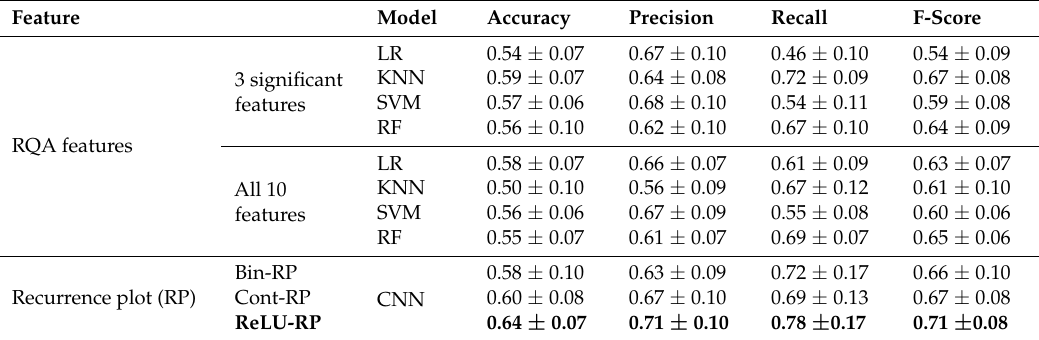
Table 4. Drowsy/awake classification performance using PPG band signals; performance measures were calculated based on 10-fold